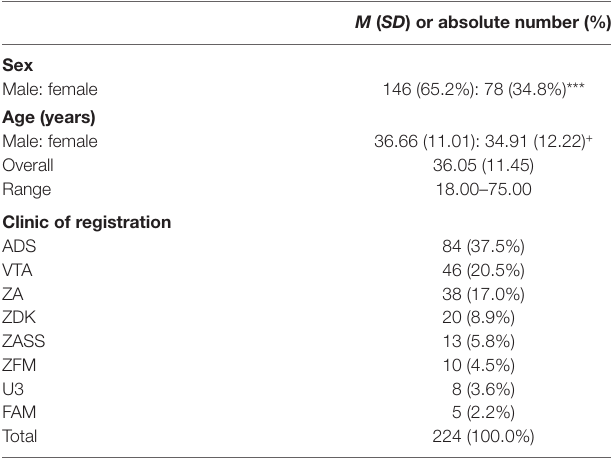
TaBle 1 | Characteristics of participants ( N = 224) and clinics of